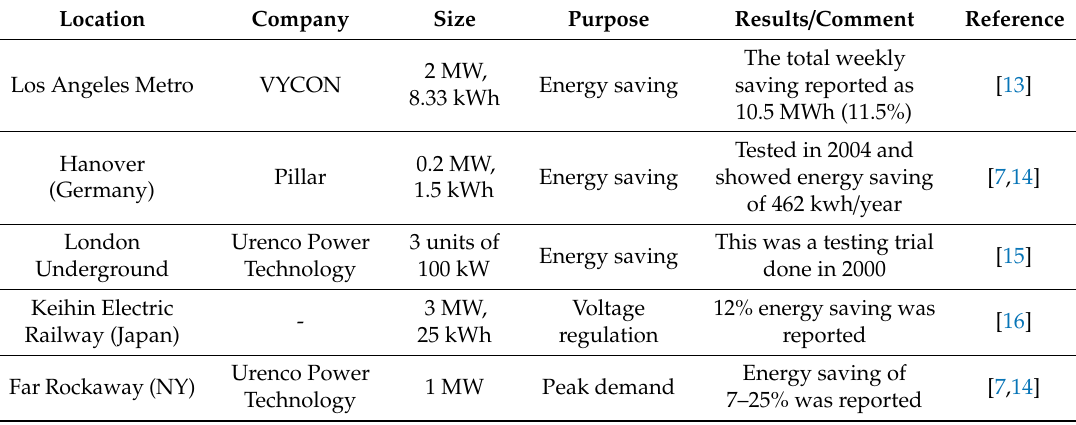
Table 1. Application of flywheel energy storage in rail transit